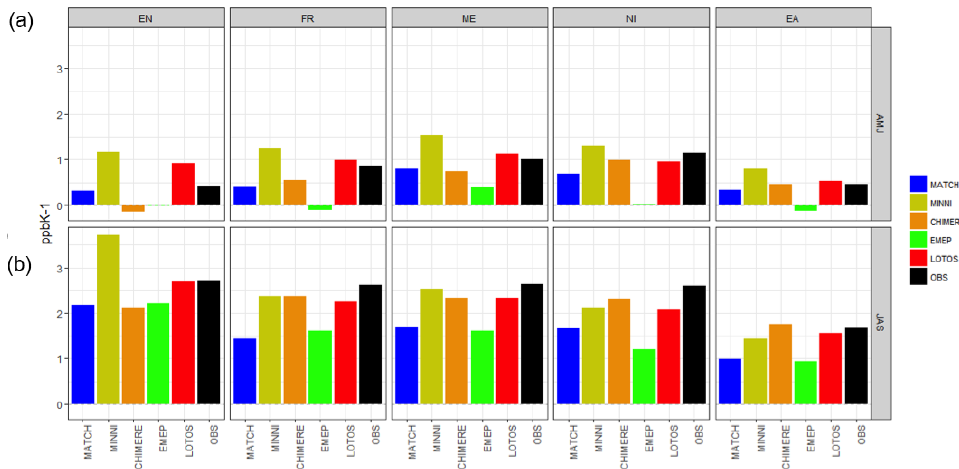
Figure 10. Slopes ( m O3 − T ; ppbK − 1 ) obtained from a simple linear regression to estimate the relationship of ozone–temperature for each CTM-based (ordered as in Fig. 3) and observation-based MLR in AMJ (a) and JAS (b) and for the internal regions: England (EN), France (FR), central Europe (ME), northern Italy (NI) and eastern Europe (EA).